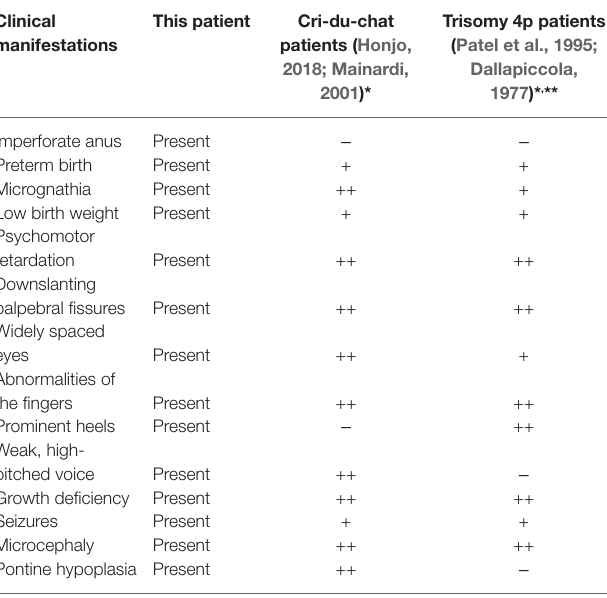
TABLE 1 | Comparison of the clinical manifestations of this patient, and previously reported patients with Cri-du-chat syndrome and Trisomy 4p